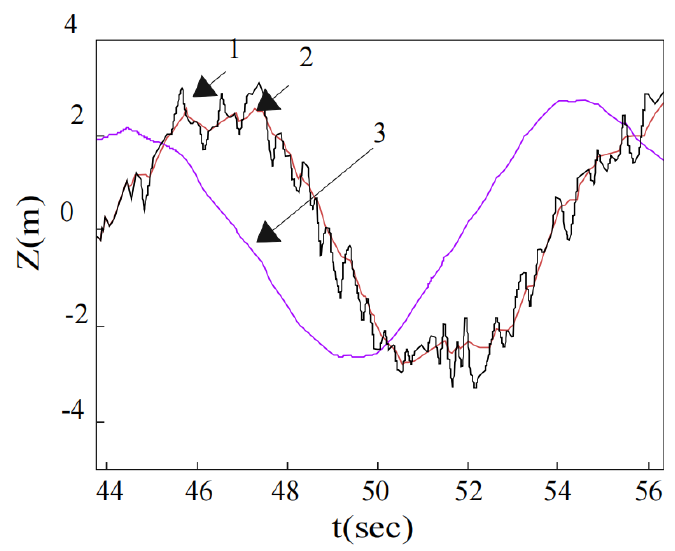
Figure 5. Curve of up and down motion and the prediction one of it.